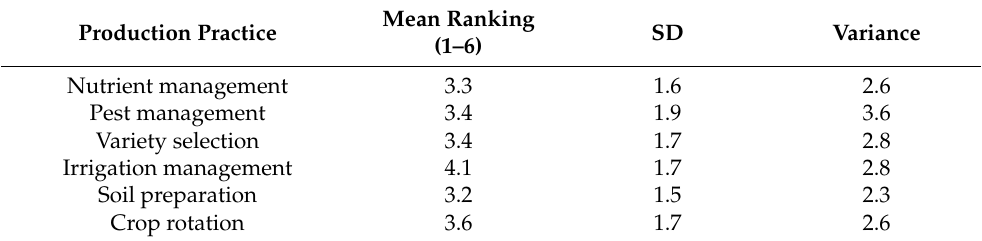
Table 1. Ranking of production practices by order of importance (6 indicates most important) by commercial farmers at the 2019 Mid-Atlantic Fruit and Vegetable Convention in Hershey, PA, USA; n = 110.